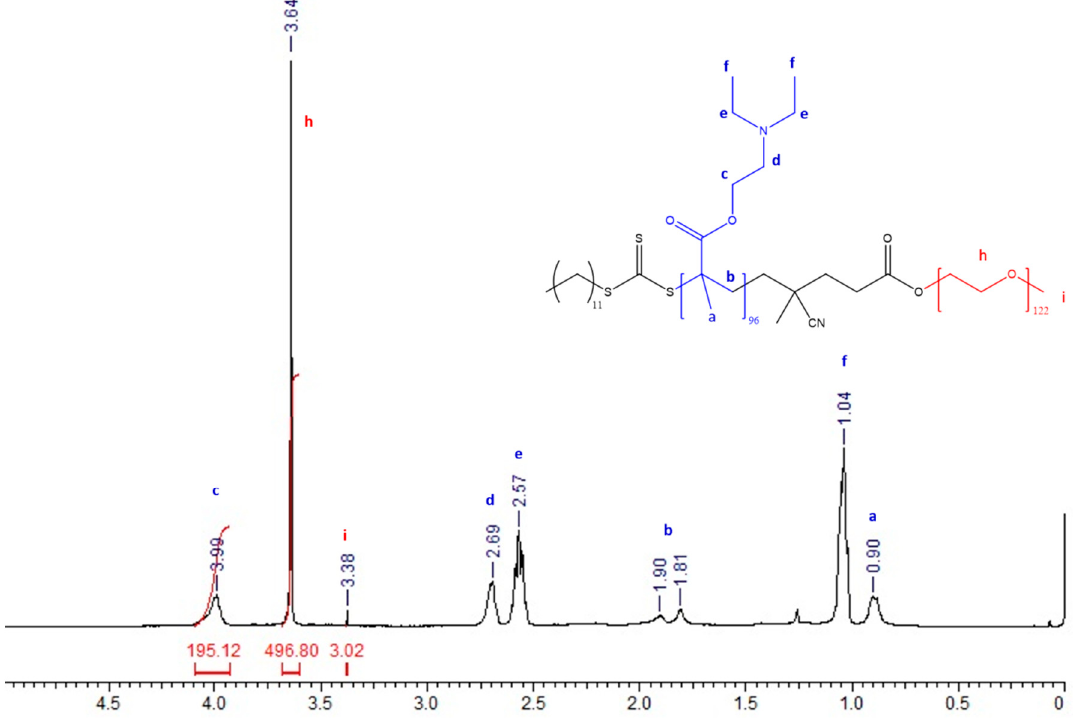
Figure 2. 1 H-NMR (400 Hz, CDCl 3 ) spectra for the block copolymer PEG 122 - b -PDEAEM 96 .